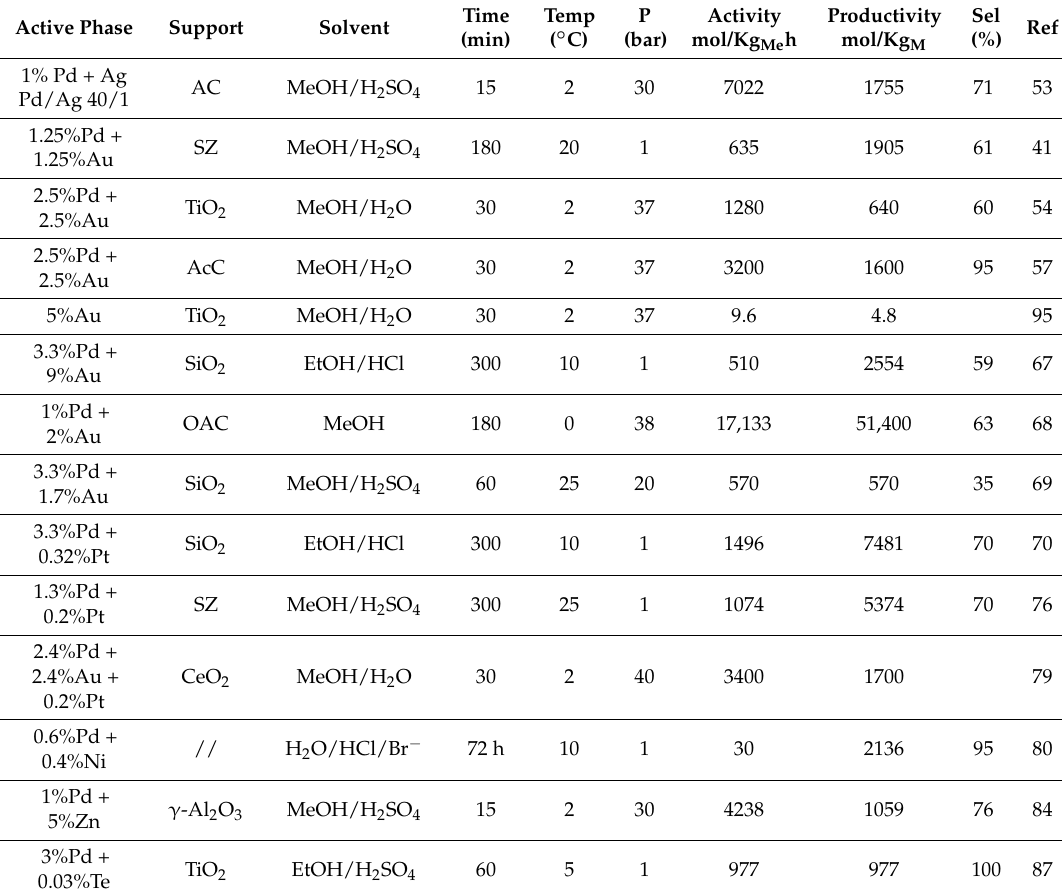
Table 1. Some representative examples of metal promoted/alloyed catalysts and their use in the direct oxidation of hydrogen